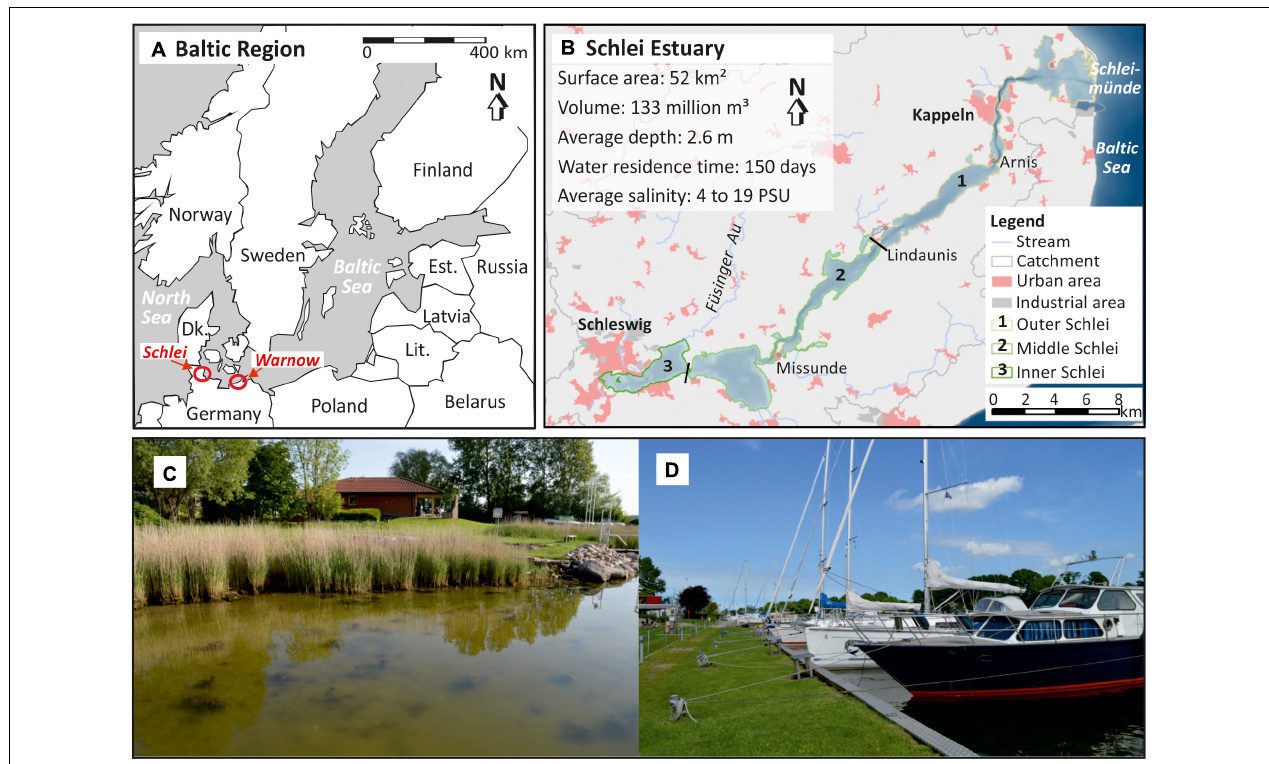
FIGURE 1 | (A) Location of the Schlei and the Warnow Estuary at the Baltic Sea coast of northern Germany, (B) basic geographical information about the rural surrounding of the Schlei Estuary and the boundaries of the inner, middle and outer Schlei, (C) the coastline of the shallow Schlei is accompanied by reed belts, and (D) today, especially water-related tourism determines the visual